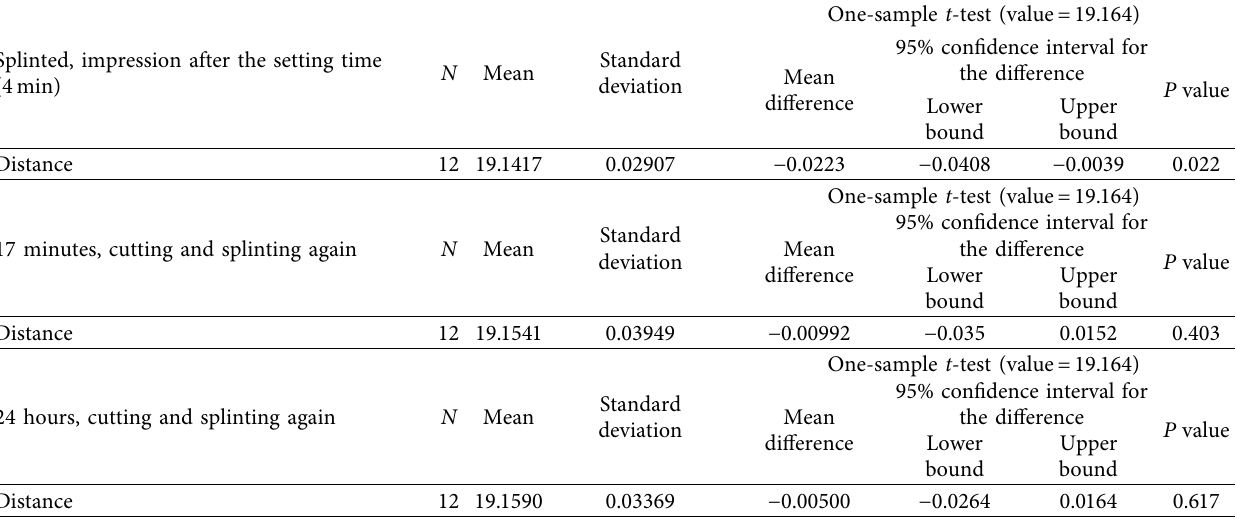
Table 1: Comparison of impression